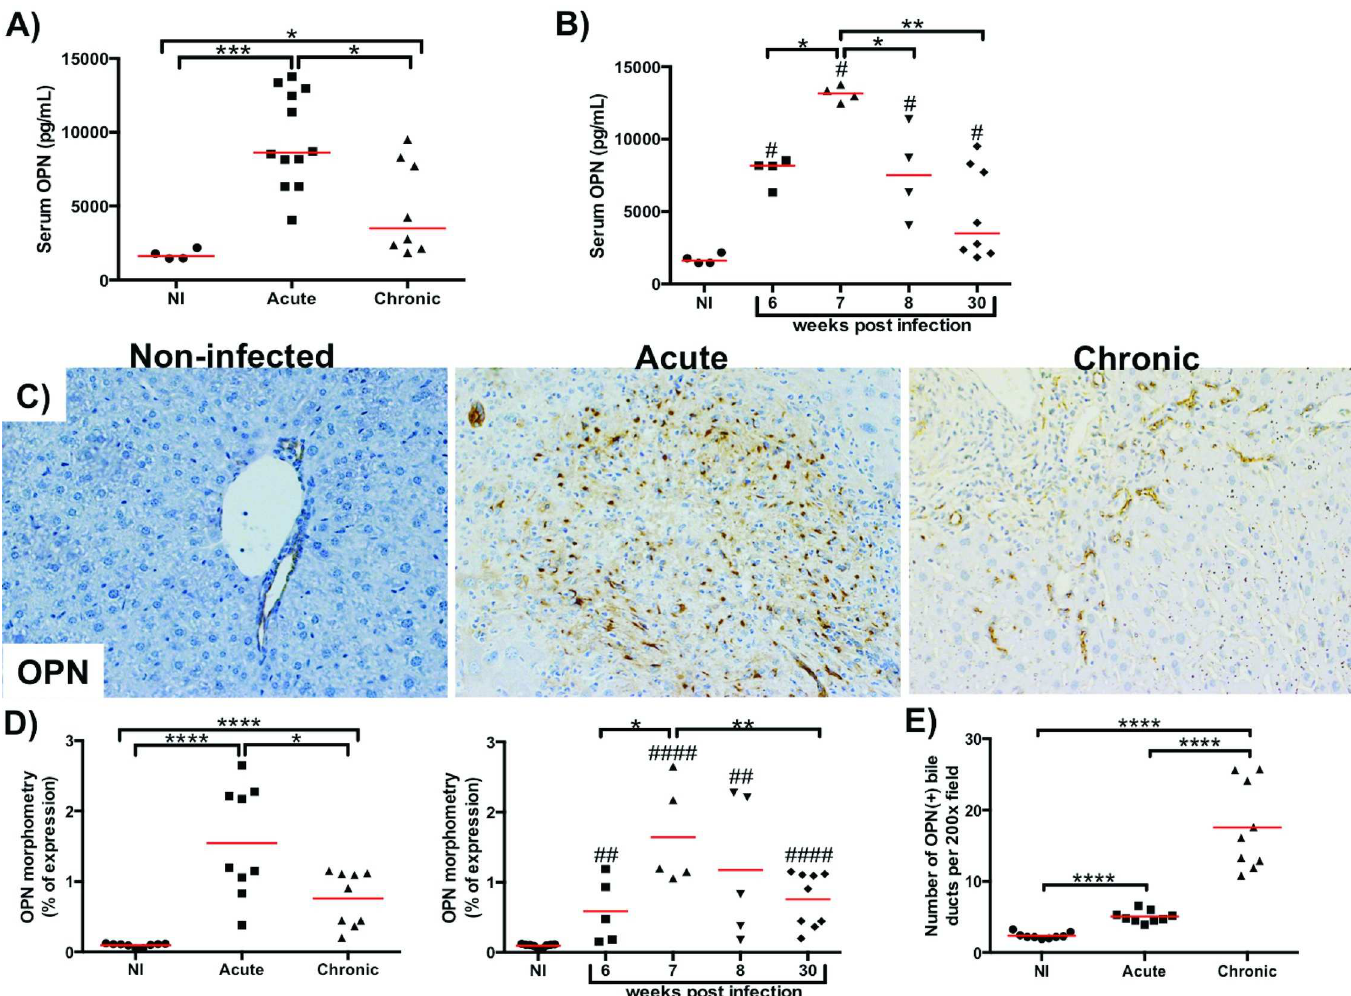
Fig 2. Sera and hepatic osteopontin are upregulated in the acute phase of murine schistosomiasis mansoni. A) ELISA for osteopontinin the serum of uninfected(NI) mice and mice experimentally infected with S . mansoni in the acute (6,7 and 8 weeks post infection) and chronic phase (30 weeks post infection). Medians are displayed,Mann-Whitney U test: * p < 0.05, ** p < 0.01, *** p < 0.001, **** p < 0.0001. B) Serum osteopontinELISA of uninfected controls and infected mice groupedby weeks post infection. Medians are displayed, Mann-Whitney U test: #p < 0.05, ##p < 0.01,###p < 0.001, ####p < 0.0001 vs non-infected; * p < 0.05, ** p < 0.01, *** p < 0.001, **** p < 0.0001. C) Immunohistochemistry for osteopontin in representative liver section of uninfected mice (left), infected mice in the acute phase (middle) and infected mice in the chronic phase (right). Final magnification 200x. D) Morphometry of